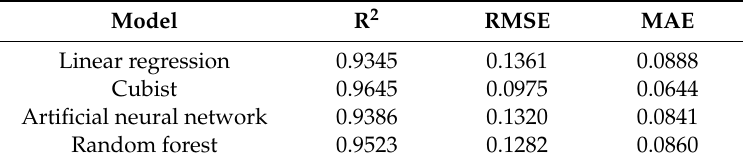
Table 2. The performance of different prediction models for test data.